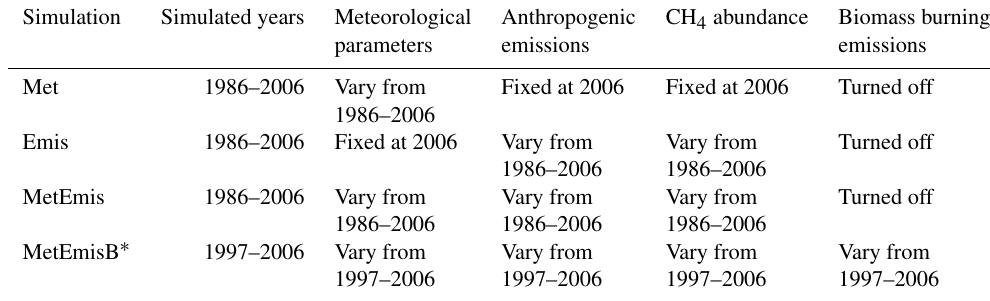
Table 3. The experimental design of the simulations for 1986–2006. Simulation Simulated